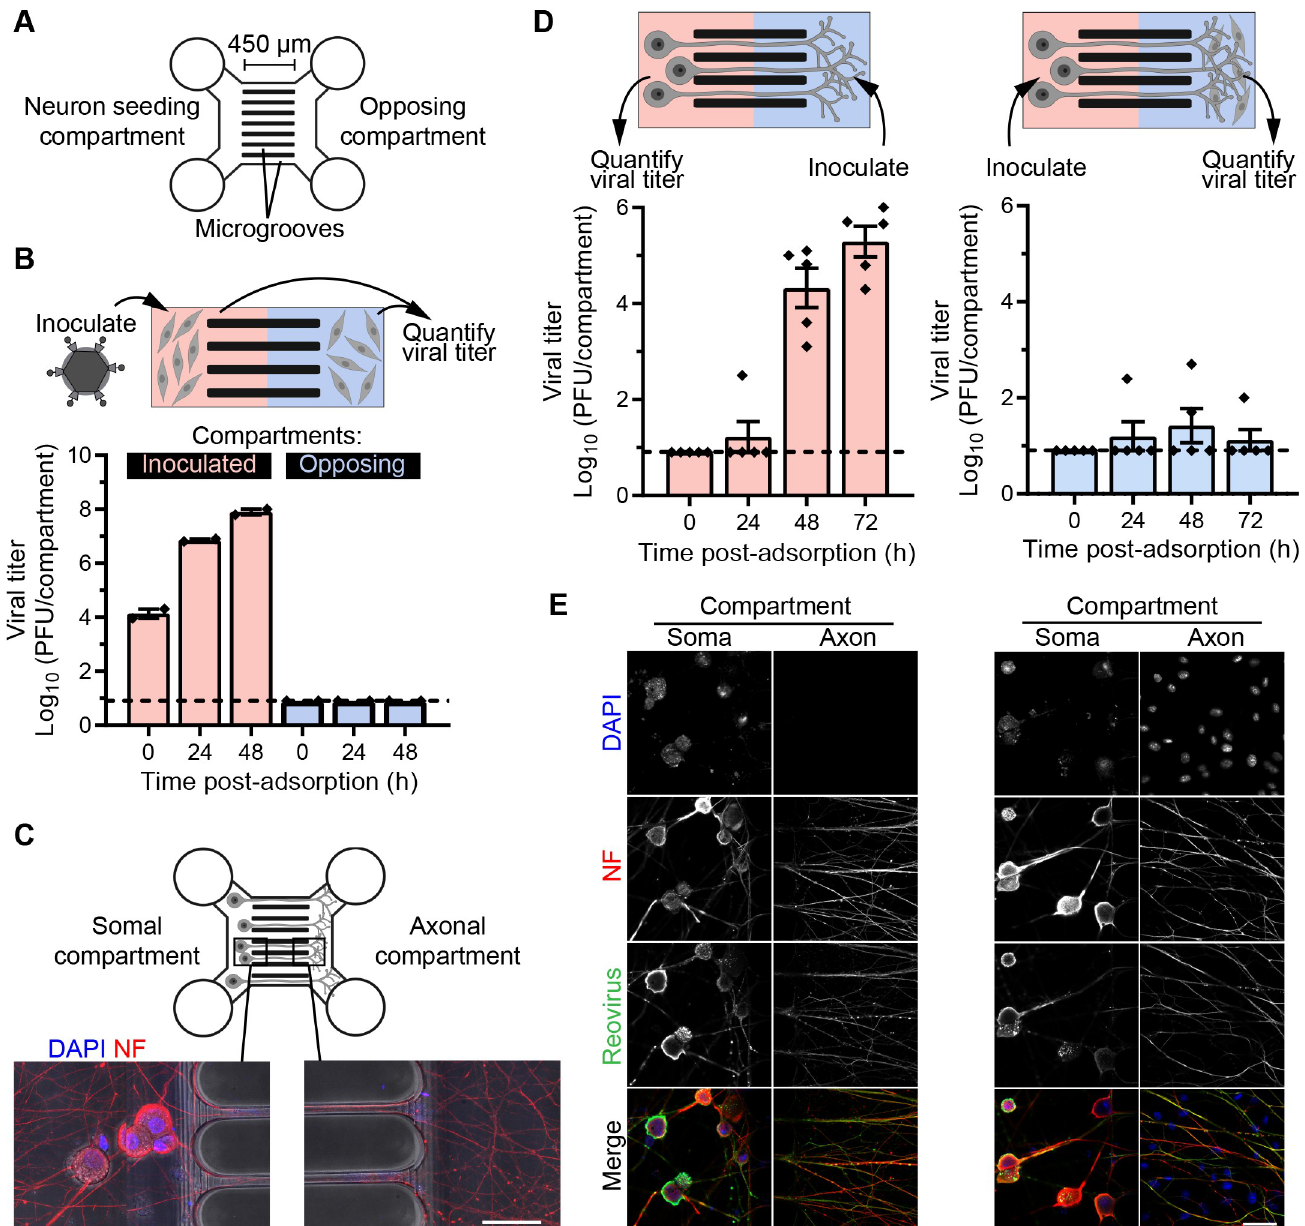
Fig 2. Anterograde spread of reovirus is limited in DRGNs. (A) Schematic of a microfluidic device with two compartments connected by 450- μ m-long microgrooves. (B) L929 cells were cultivated in both compartments (red and blue) of the microfluidic device. Cells in the left compartment were adsorbed with T3SA+ virions at an MOI of 10 PFU/cell, and viral titers in culture supernatants from both inoculated and opposing compartments were determined at the indicated times post-adsorption. Bars indicate mean titers of duplicate devices from one representative experiment. Error bars indicate SEM. (C) Representative micrographs show somal and axonal compartments of a microfluidic device with DRGNs cultivated for 7 days and stained with markers for nuclei (DAPI) and axons (non-phosphorylated neurofilament H, NF). (D-E) DRGNs cultivated in microfluidic devices were adsorbed with T3SA+ virions in the somal or axonal compartment as indicated in the schematics (D, top). L929 cells were cultivated in the axonal compartment to amplify virus released by anterograde spread following inoculation of the somal compartment. Viral titers in the culture supernatant in the compartment opposing the inoculated compartment at the indicated times post-adsorption are shown (D). Bars indicate means, and error bars indicate SEM. Individual data points represent titers from five devices in total from three independent experiments. Devices were fixed at 72 h post-adsorption and immunostained with reovirus antiserum and a neuronal marker (NF). Representative micrographs of somal and axonal compartments corresponding to the experimental setup in (D) are shown in (E). Scale bars, 50 μ m. In B and D, dashed lines mark the limit of detection.